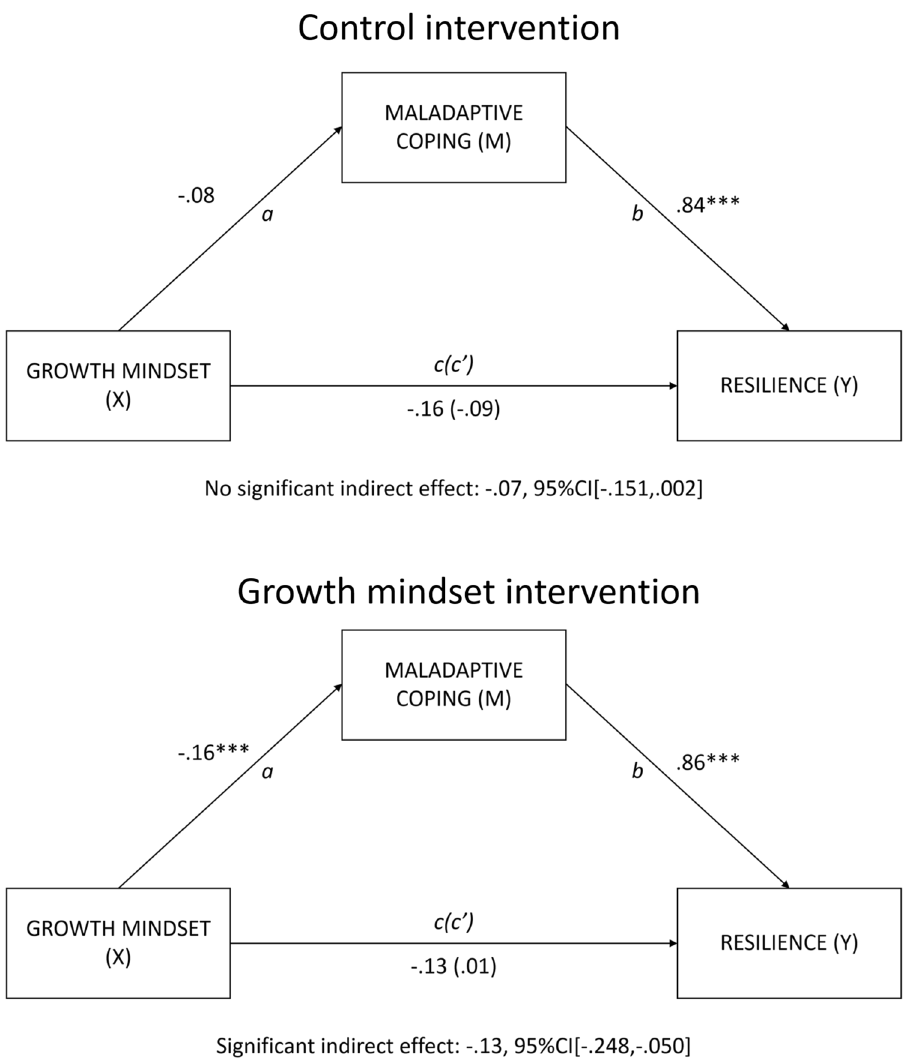
Figure 4. Mediation results: separately for control and growth mindset intervention groups. Note. N ( control intervention group) = 130. N ( growth mindset intervention group) = 131. X = independent variable. Y = dependent variable. M = mediator. The control and growth mindset interventions took place one year before the pandemic started (two years before the peri-pandemic measures). Note, growth mindset and maladaptive coping were measured during the pandemic (T3). The resilience variable was defined as residuals of the regression between school burnout symptoms and COVID-related stress exposure (at T3), controlling for pre-pandemic school burnout symptoms (T2). Note that the resilience variable is reversed. * p < .05, ** < .01, *** < .001; path c’ = direct effect; numbers are beta